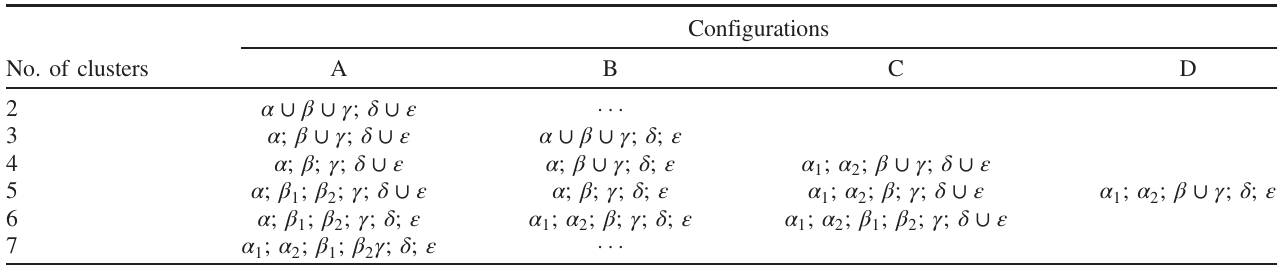
TABLE VI. Possible cluster configurations obtained by merging together the seven clusters found by means of I k evaluation. α ¼ α ∪ α ; β ¼ β ∪ β 1 2 1 2 .